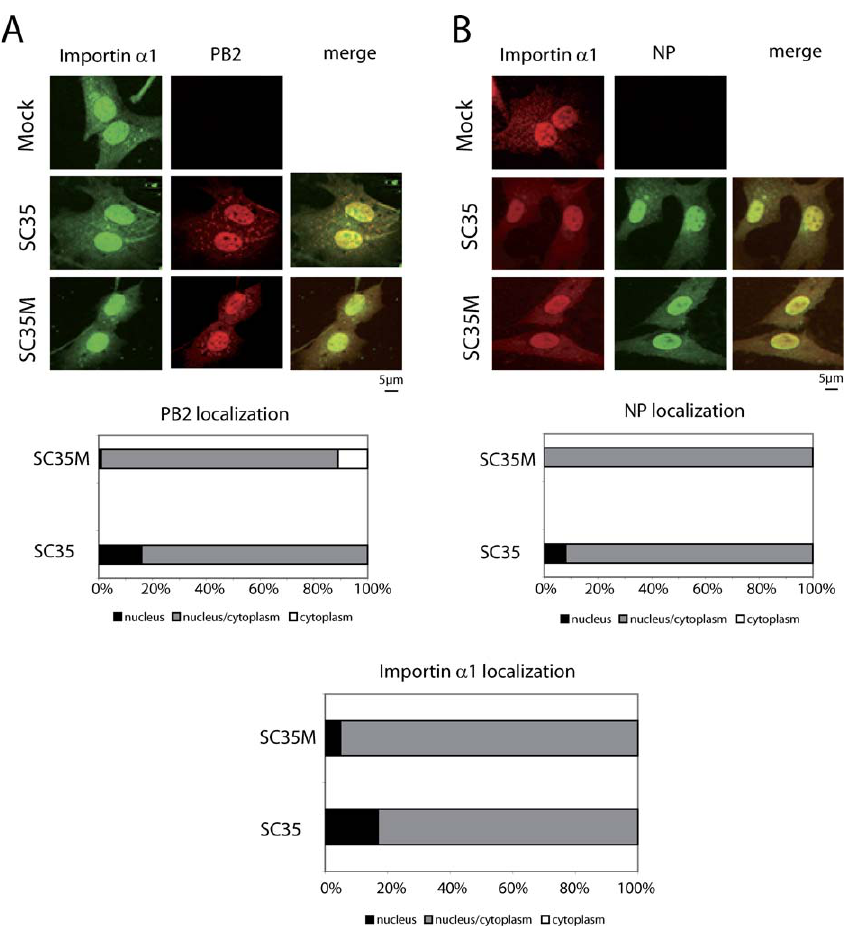
Figure 7. Localization of PB2, NP, and Importin a 1 in Avian Cells CEC-32 cells were infected with SC35 and SC35M at MOI 2. 12 h p.i. cells were stained with antisera specific for importin a 1 (secondary antibody FITC- coupled) and viral PB2 (secondary antibody Rhodamine-coupled) (A) or importin a 1 (secondary antibody Rhodamine-coupled) and NP (secondary antibody FITC-coupled) (B). The amounts of PB2, NP, and importin a 1 in the nucleus and the cytoplasm are indicated by bars. Quantification was done as described in Materials and